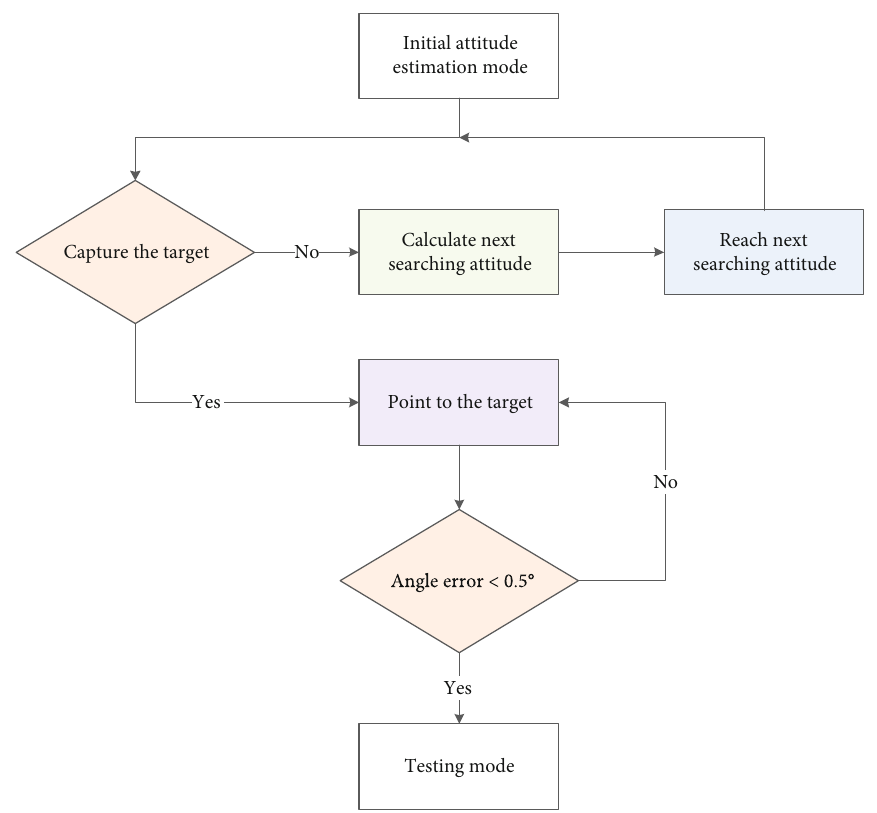
Figure 3: Framework of the target searching